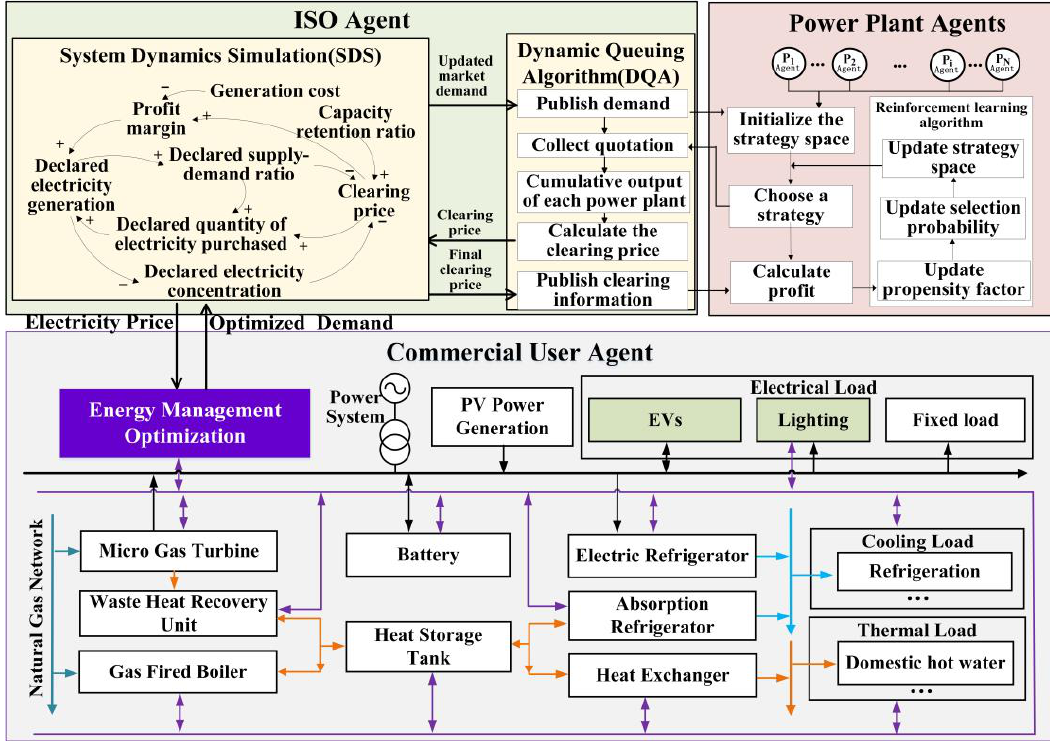
Figure 1. Energy management optimization theoretical framework based on the hybrid simulation of the electricity market bidding.